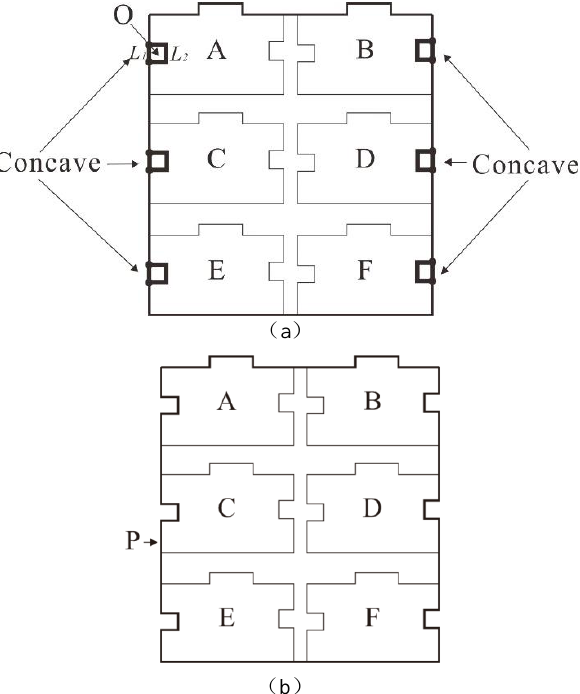
Figure 7. Restoration of the concave structure. (a) Concave identification; (b) boundary of the structured geographic